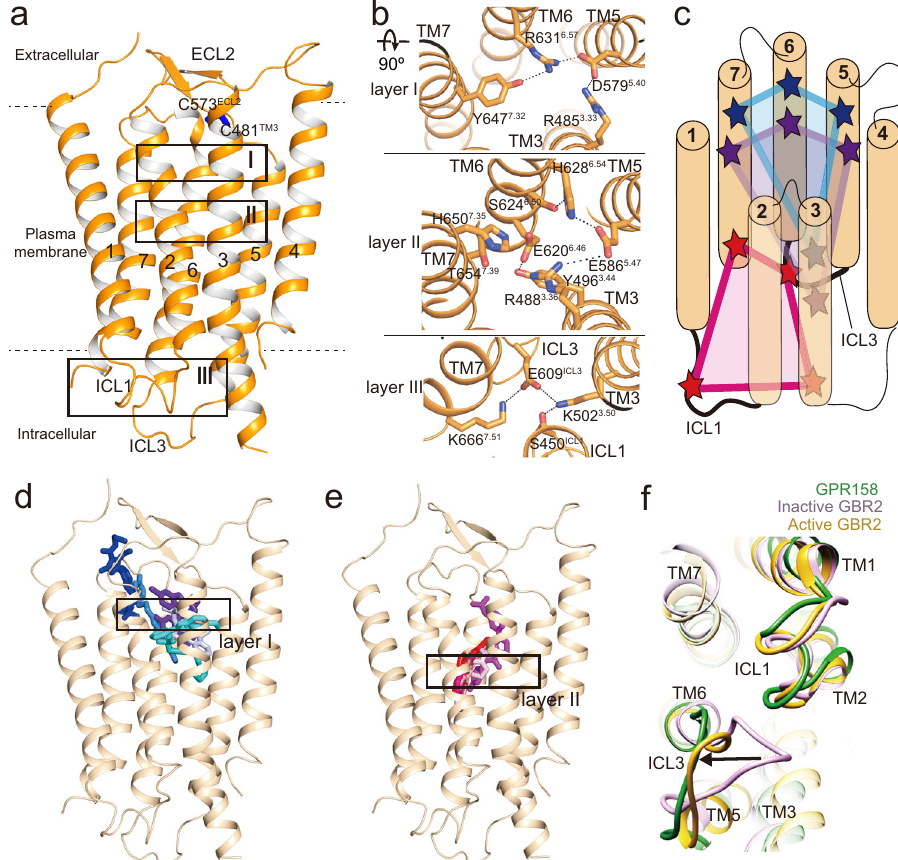
Fig. 3 Structure of the TM domain in comparison with other GPCRs. a Overall structure of the 7TM domain of GPR158. The opposite protomer is omitted for clarity. Boxes include clusters of interactions within a TM domain. The disul fi de bond between ECL2 and TM3 are colored blue. b Close-up views of the three layers of ion pairs within a TM domain in an orthogonal view from a . The ionic and polar interaction network in layer I (top) and II (middle) stabilize TM3, 5, 6, and 7. c Cartoon representation of intra-TM domain interactions formed by layer I (blue), II (purple), and III (pink). d , e Location of the orthosteric ligands bound to class A ( d ) and the allosteric ligands bound to class C ( e ) GPCRs in comparison with layer I and II within the GPR158 TM domain (light orange). The ligands are shown as sticks and colored as follows: GPR52 (6LI0, blue), MT1 (6ME3, cyan), mAChR (6OIJ, purple blue), A2A (6S0L, sky blue), OX1R (6V9S, purple), and ADRB2 (6OBA, light blue) from class A ( d ), and mGluR1 (4OR2, magenta) and mGluR5 (4OO9, light pink; 5CGC, red; 5CGD, raspberry; 6FFH, salmon; 6FFI, hot pick) from class C ( e ). f Comparison of TM domain structures between GPR158 and inactive or active GABA B by aligning TM domains of GPR158 with the corresponding GBR2 structures. Conformational differences in ICLs between GPR158 and inactive GBR2 are indicated by an